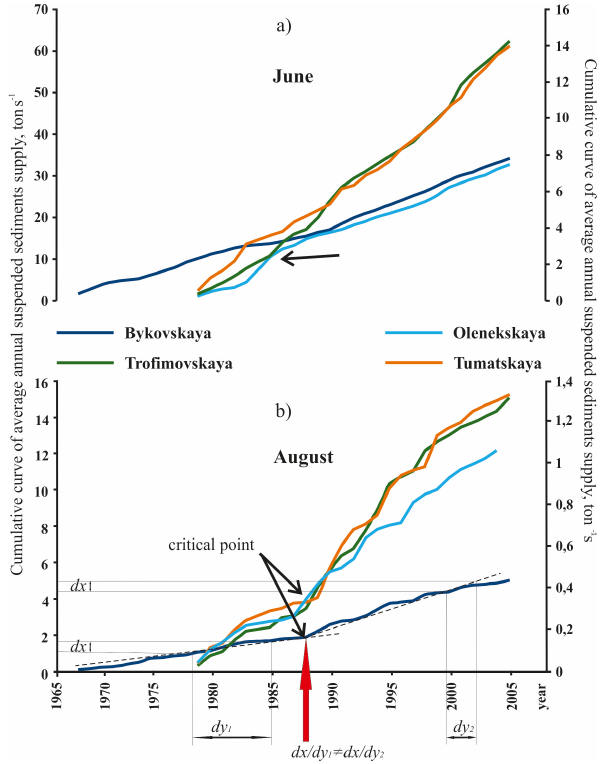
Figure 5. Cumulative average monthly suspended sediment supply from the main delta branches based on data from the Russian hy- drometeorological network for June (a) and August (b) . The right y -axis is for the Olenekskaya and Tumatskaya branches; the left y -axis is for the Bykovskaya and Trofimovskaya branches. The ar- rows indicate points at which the rate of increase of cumulative sus- pended sediment discharge shifts; dashed lines are trend lines.